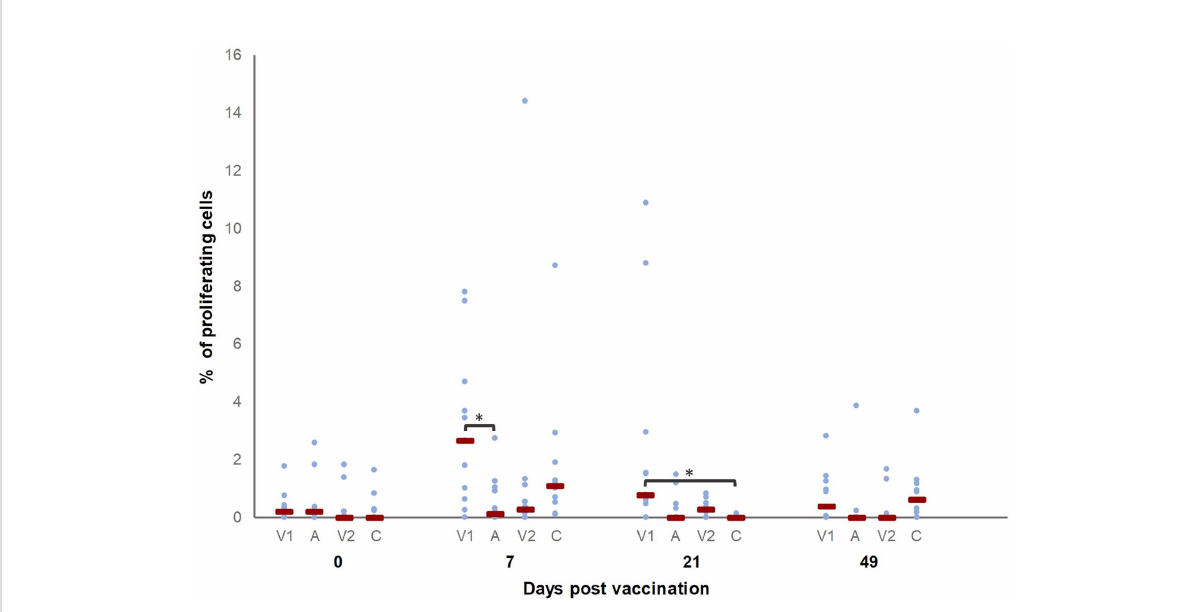
FIGURE 4 Percentage of M. hyopneumoniae -speci fi c proliferating CD3 + T cells. Piglets were vaccinated on D0 with V1, A, V2 or physiological saline solution (C), and animals were challenge infected on D21 and euthanized on D49. The percentage of M. hyopneumoniae -speci fi c proliferating CD3 + T cells was determined with a recall assay. First, for each time point, signi fi cant differences between groups were evaluated using a Kruskal – Wallis H-test with Dunn-Bonferroni post hoc test. Next, the effect of sampling time was evaluated within each group using a generalized estimating equation procedure with an identity link function, accounting for repeated measurements on a pig level in an exchangeable correlation matrix and using D0 as the reference category. Data are considered relevant if signi fi cant differences were observed between the groups on a speci fi c sampling day, and if there was a signi fi cant effect of sampling time for (at least) one of the groups on this sampling day. Statistical results were considered signi fi cant when p ≤ 0.05 (*). The percentage of proliferating CD3 + T cells was higher on D7 and D21 as compared to D0 in